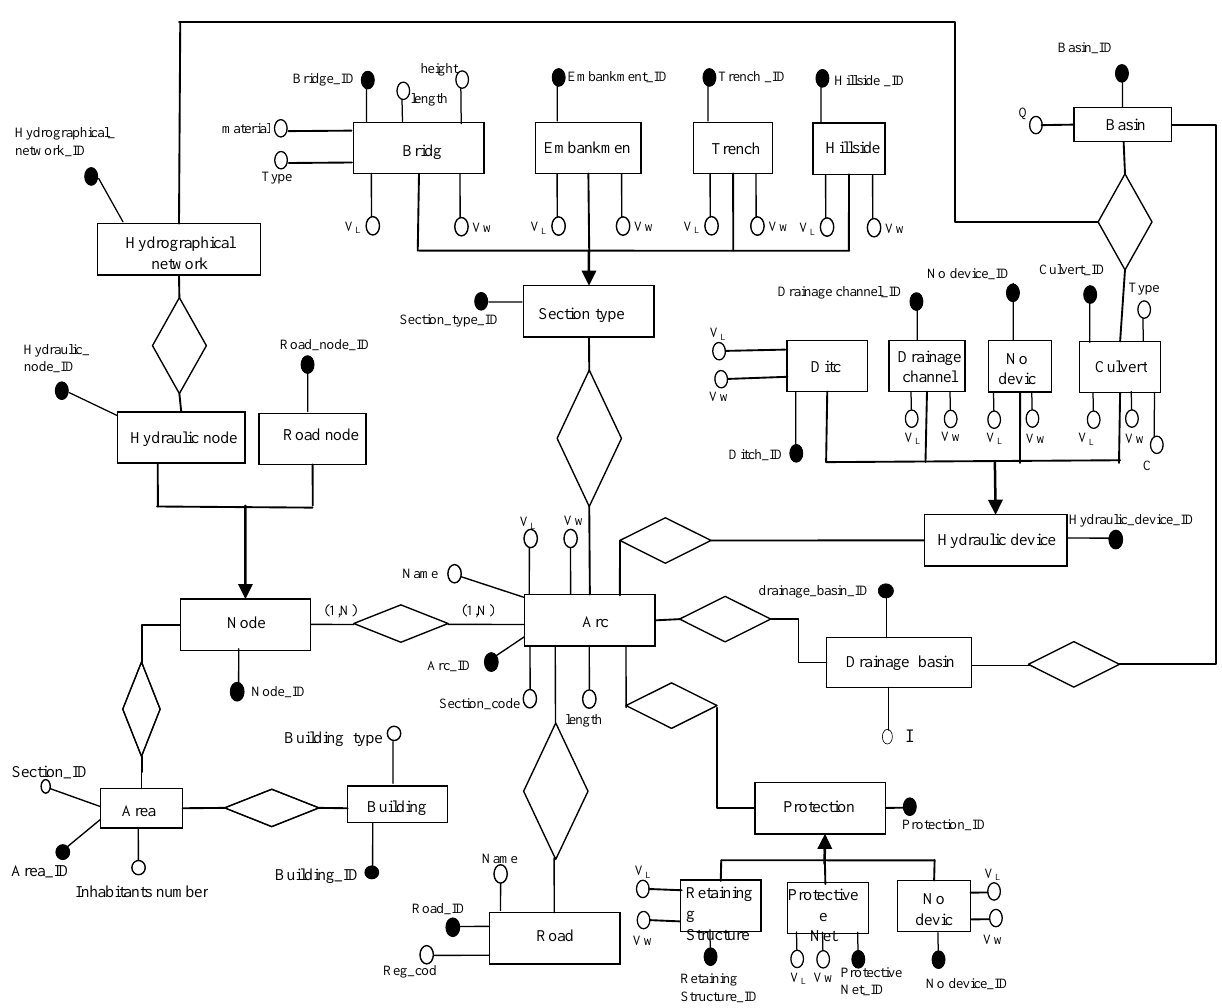
Figure 6. Simplified E-R diagram relating to the conceptual design of the data structure